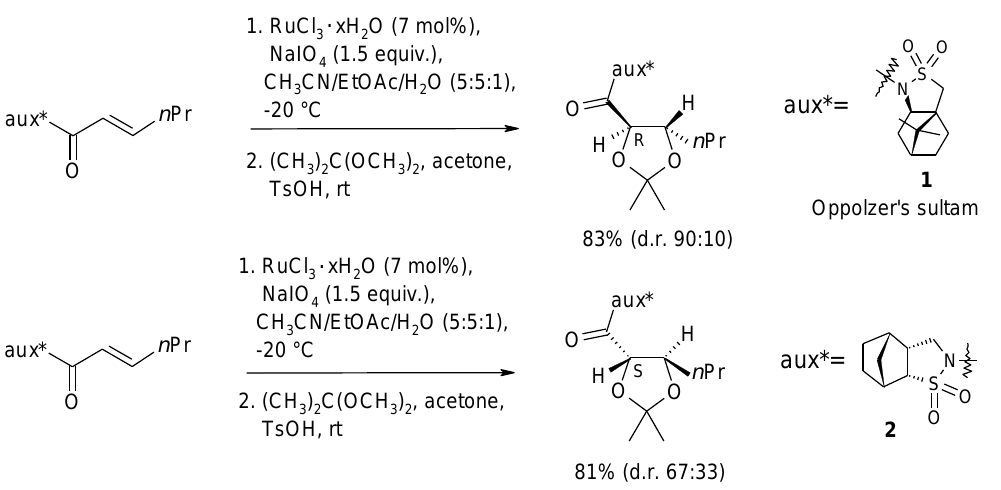
Scheme 2. Examples of diastereoselective dihydroxylation of α  β-unsaturated carbonyl compounds (major diastereomers shown)